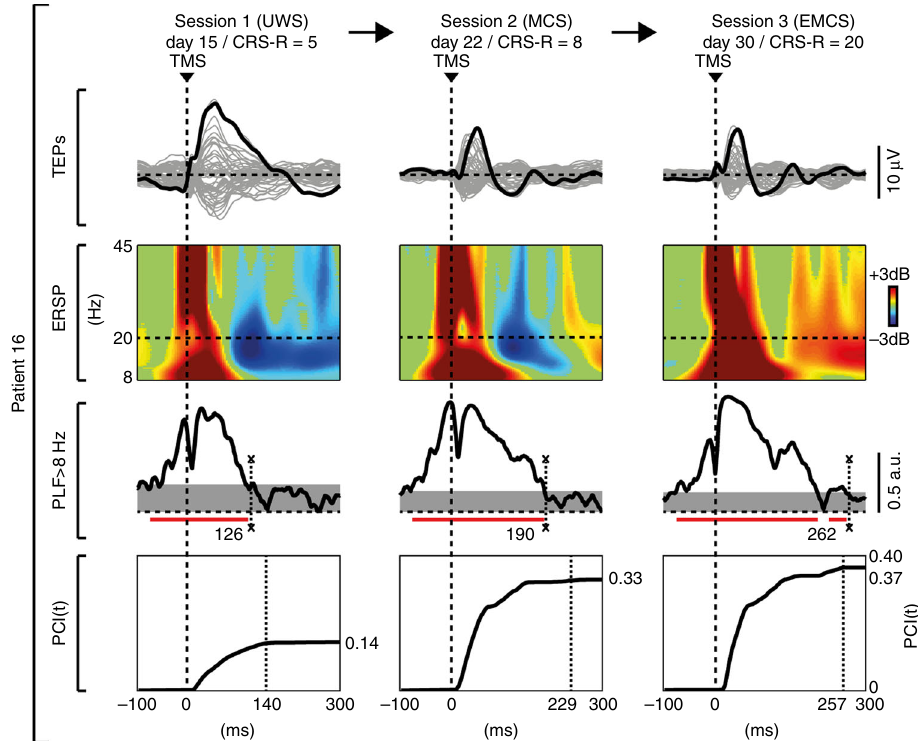
Fig. 5 Longitudinal measurements in one UWS patient who evolved to EMCS, through MCS. In Patient 16 (see Supplementary Table 2) the fi rst behavioral and TMS/EEG assessments (Session 1) were carried out 48 h after withdrawal of sedation, as patient exited from coma 26 . The butter fl y plot of the TMS- evoked EEG potentials recorded from all 60 channels (gray traces), the corresponding ERSP and the PLF time course of the channel with the largest response are shown for each clinical diagnosis (UWS, MCS, and EMCS) together with the temporal evolution of PCI. In the ERSP plot, red color indicates a signi fi cant ( α < 0.05) power increase compared to the baseline, blue color a signi fi cant power decrease and the green color a non-signi fi cant activation. The dashed horizontal line marks the 20 Hz frequency bin. The last signi fi cant ( α < 0.01) time point in the PLF (above 8 Hz) is marked by a thin dashed vertical line. Time points above statistical threshold (gray shaded area) are underlined by a red horizontal line. The thick dashed vertical line indicates the occurrence of TMS. The time at which PCI reaches its maximum value (max PCIt) is indicated by a thin dashed vertical